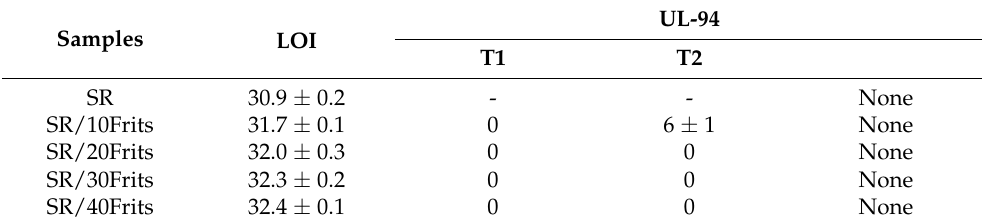
Table 3. LOI and UL-94 results of SR/frit